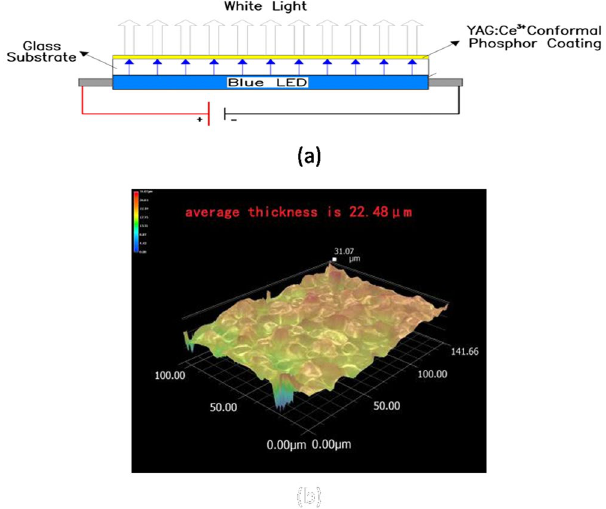
Figure 1. ( a ) Experimental Set –up for this work. ( b ) Optical Micrograph of a phosphor coating on glass